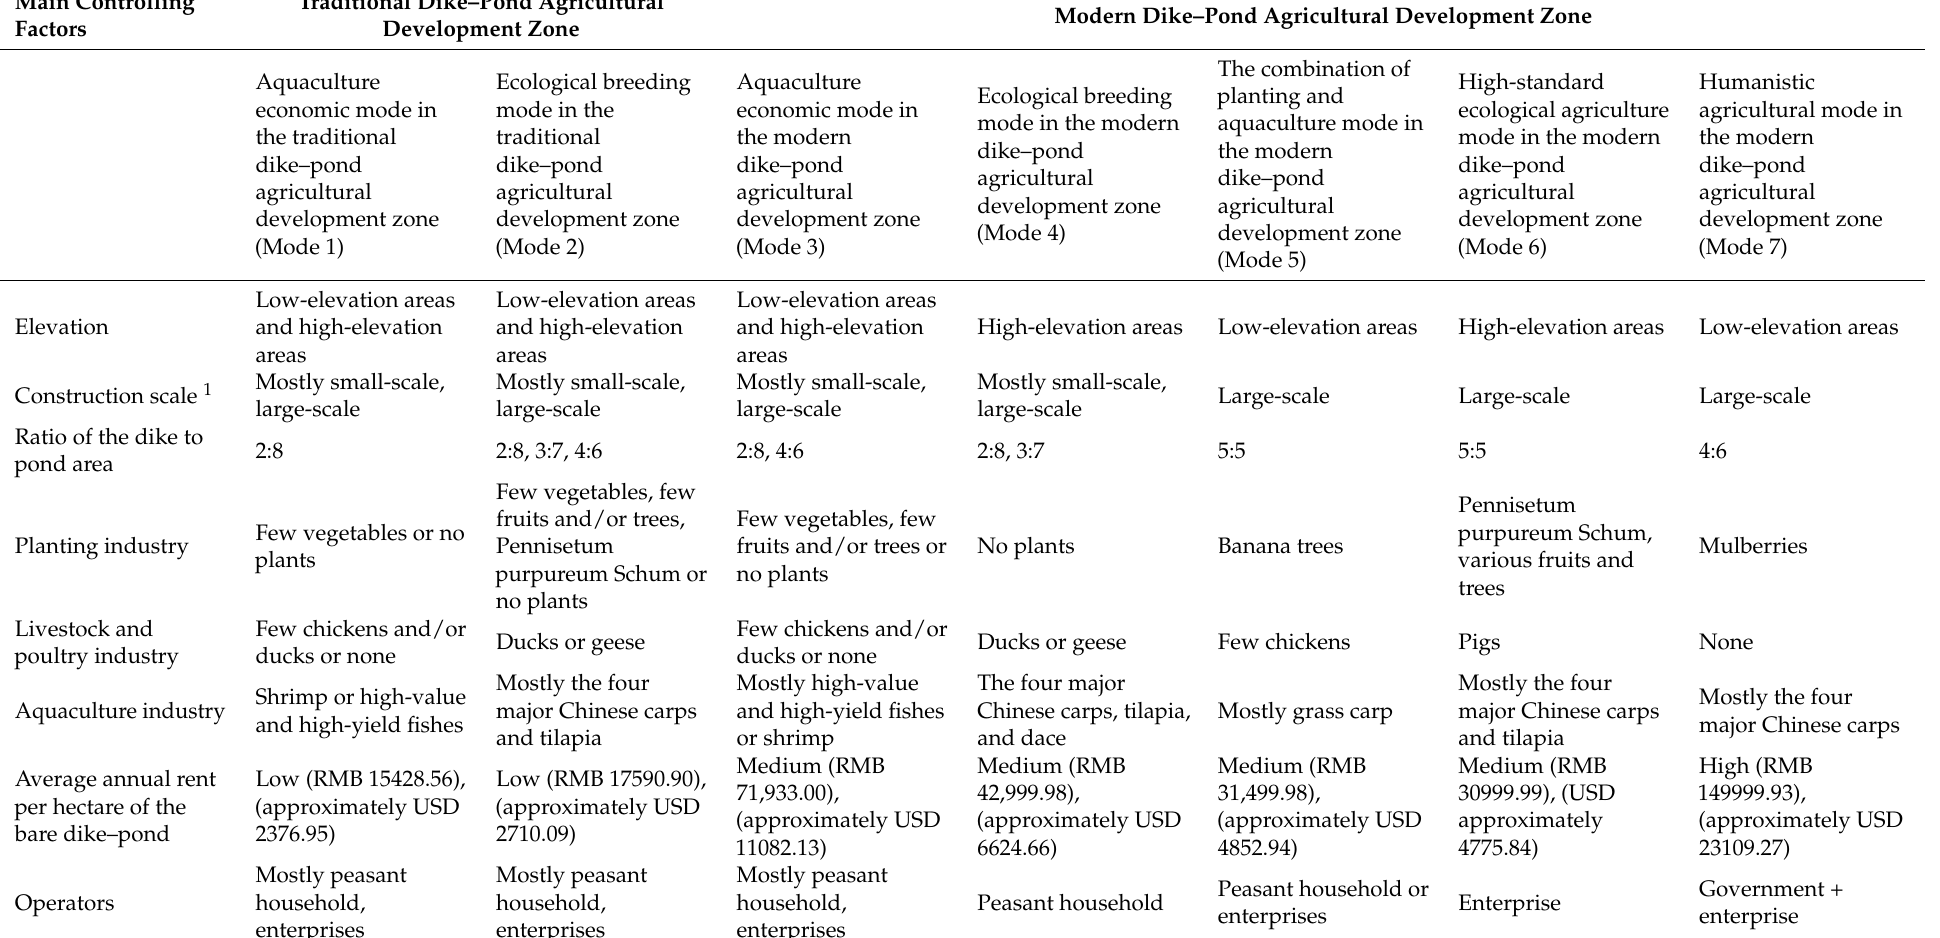
Table 2. Characteristics of the land-use modes of dike–pond